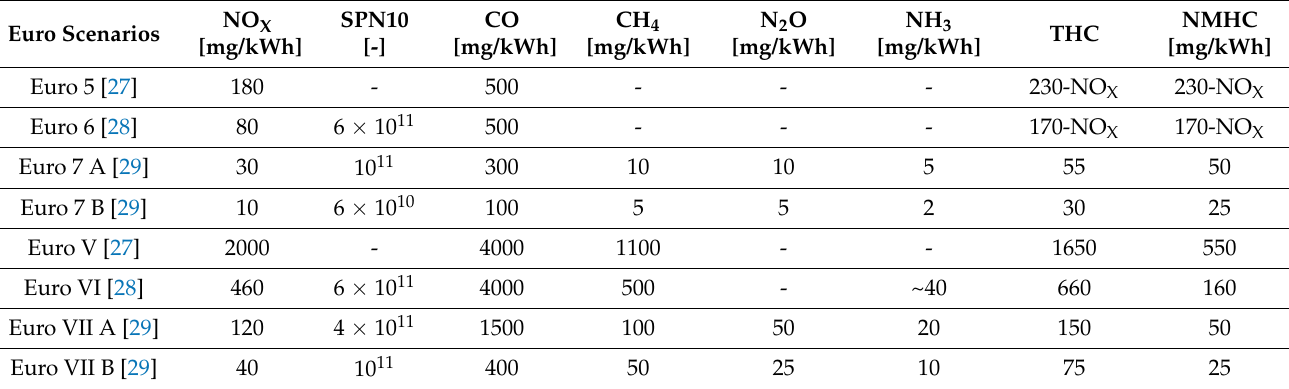
Table 1. A tabular overview of the emission limits of the individual exhaust gas components for the different Euro standards, with revisited emission limits according to the alternative scenarios for Euro 7